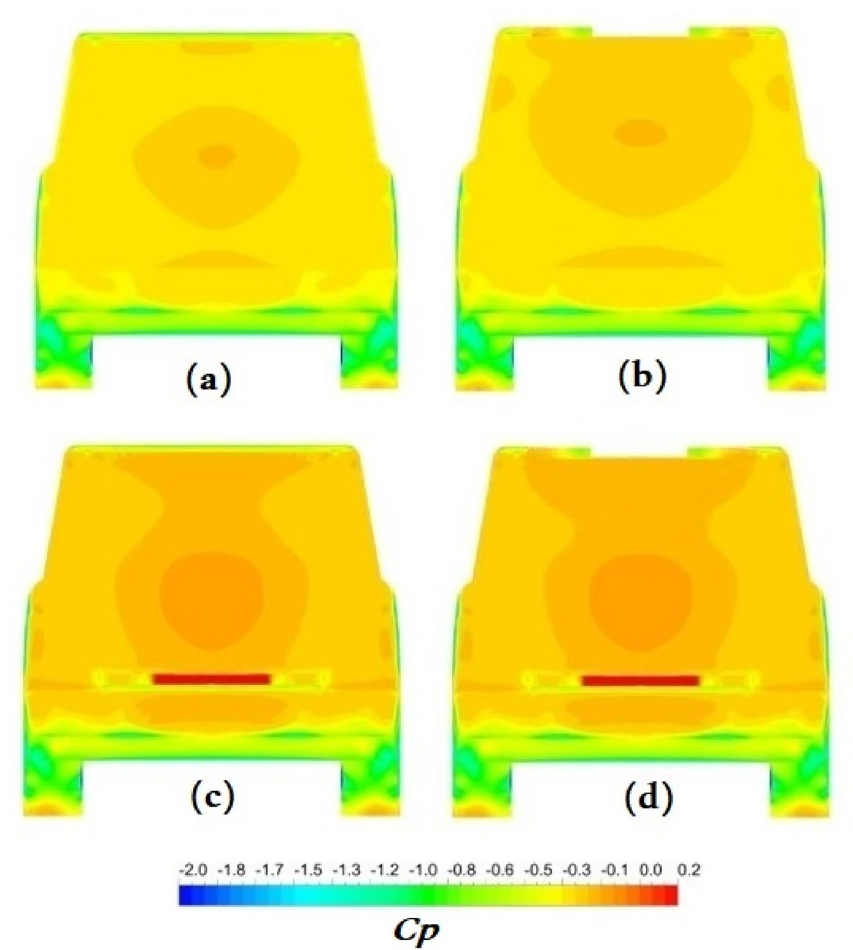
Figure 18. Pressure distribution on the surfaces of the Discovery car from the back view: ( a ) the baseline model, ( b ) the modified roof model, ( c ) the ventilation duct model, ( d ) the combined model.